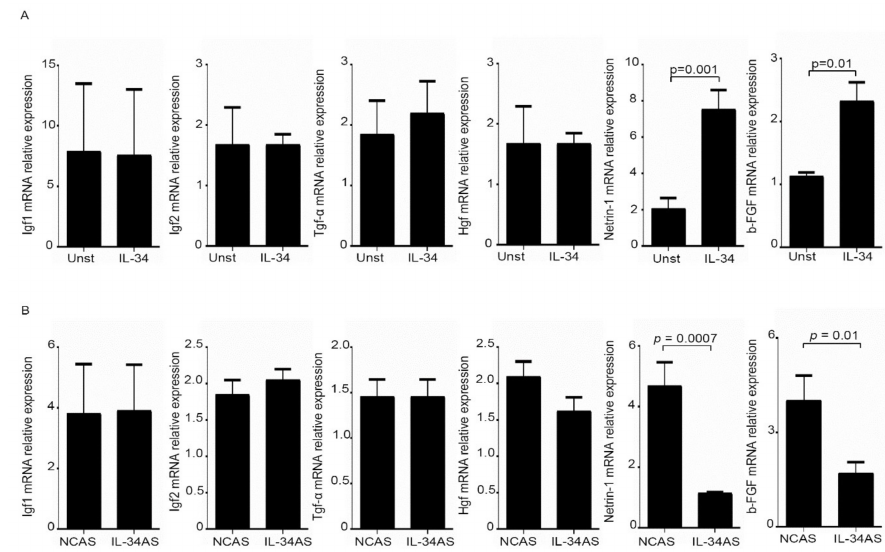
Figure 6. IL-34 induces Netrin-1 and b-FGF RNA expression. ( A ) Serum-starved normal fibroblasts (NFs) were treated with IL-34 (50 ng / mL) for 6 h and Igf1; Igf2, Tgf- α , Hgf, Netrin-1 and b-FGF RNA transcripts were analyzed by real-time PCR; levels were normalized to β -Actin and data were expressed as mean ± SEM of six experiments in which cells of six patients were analyzed. ( B ) CAFs were transfected with either negative control antisense oligonucleotide (NCAS) or IL-34 antisense oligonucleotide (IL-34 AS) for 24 h and Igf1; Igf2, Tgf- α , Hgf, Netrin-1 and b-FGF RNA transcripts were analyzed by real-time PCR; levels were normalized to β -Actin and data were expressed as mean ± SEM of six experiments in which cells of six patients were analyzed. UNST = unstimulated. As expected, netrin-1 and b-FGF protein content was increased in normal fibroblasts treated with IL-34 (Figure 7A,B), while such proteins were down-regulated in IL-34 AS-treated CAFs (Figure 7C,D).